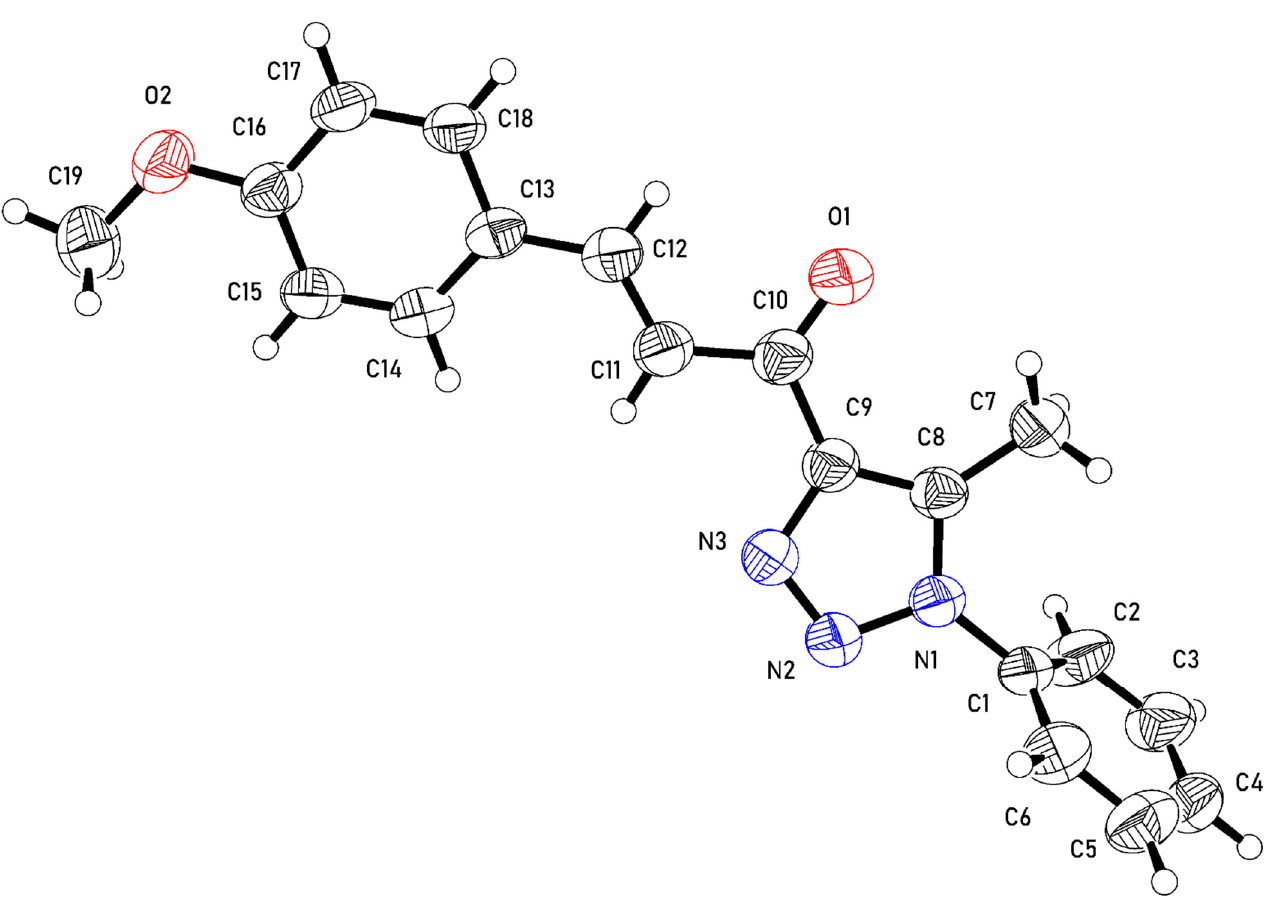
Figure 1. An ortep representation of 3a showing 50% probability atomic displacement ellipsoids. For X-ray crystal structure determination, single crystals were obtained following the crystallization of the synthesized heterocycles using dimethylformamide (DMF). The molecule of 3a (Figure 1) is constructed from phenyl A (C1–C6), methyltriazole B (C7–C9, N1–N3), propanal C (C10–C12, O1) and methoxybenzene D (C13–C19, O2) groups. Except for the phenyl group ( A ), the molecule is nearly planar as shown by the twist angles B / C and C / D of 4.23(19) ◦ and 9.82(18) ◦ , respectively. Regarding the phenyl group, twist angle A / B is 66.96(7) ◦ . The molecule of 4a (Figure 2) contains phenyl A (C1–C6), methyltriazole B (C7–C9, N1–N3), pyrazole C (C10–C12, N4, N5), methoxybenzene D (C14–C20, O1) and methanethioamide E (C13, S1, N6) groups. In the crystal, the pyrazole ring ( C ) is distorted from planarity with C12 diverging from the least squares plane of the rest of the atoms by 0.235(5)Å. The methanethioamide ( E ) and pyrazole ( C ) groups are roughly coplanar with a C / E twist angle of 10.67(21) ◦ . The methyltriazole ( B ) and pyrazole ( C ) groups are also almost coplanar with a B / C twist angle of 15.35(24) ◦ . The phenyl ( A ) and methoxybenzene ( D ) groups are significantly twisted from this plane with twist angles A / B and C / D of 78.71(12) ◦ and 87.02(11) ◦ , respectively. Hydrogen bonding of type N–H...N (N6 . . . N4 = 3.117(3)Å, N6-H6B . . . N4 = 162.1 ◦ ) and N–H..S (N6 . . . S1 = 3.506(3)Å, N6–H6A . . . S1= 138.7 ◦ ) is observed in the crystal structure. For more details, see the Supplementary